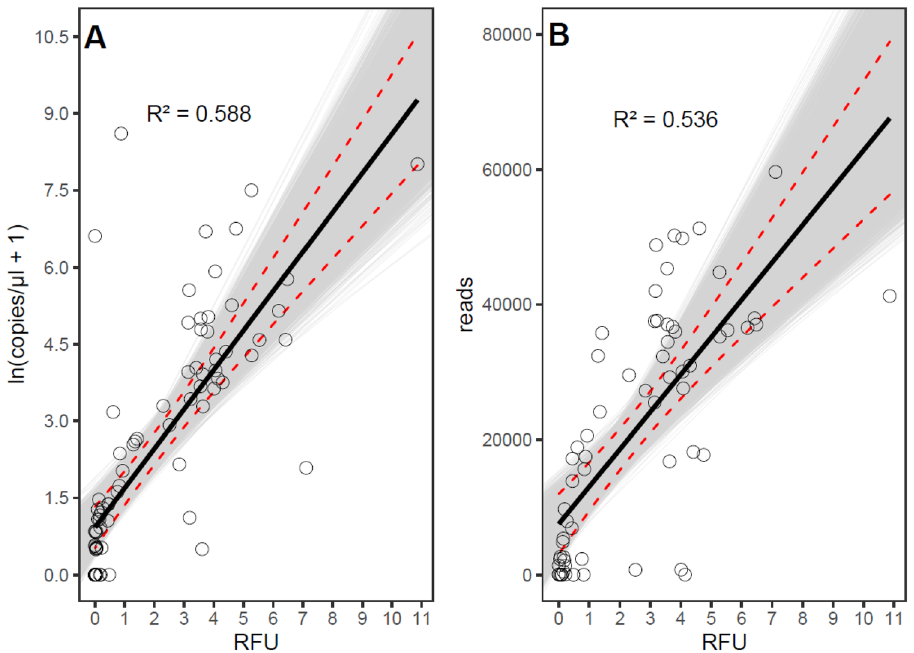
Figure 3. Signal strengths [RFU] of celPCR products of the library preparation PCR for high-throughput sequencing, plotted against ( A ) copies/µl and ( B ) Asteraceae read numbers of the plant-specific trn L c- h target fragment, measured in regurgitates of Pseudoophonus rufipes , collected at 0, 4, 8, 16, 24, 32, 48, 64, 72, and 96 h after feeding on 1–3 seeds of Taraxacum officinale. In the scatterplots, dots ( ○ ) represent measured values, black bold lines are predicted values of linear regression models, dashed lines are 95% confidence intervals, shaded area marks boot-strapped 95% confidence interval, and R 2 indicates goodness of